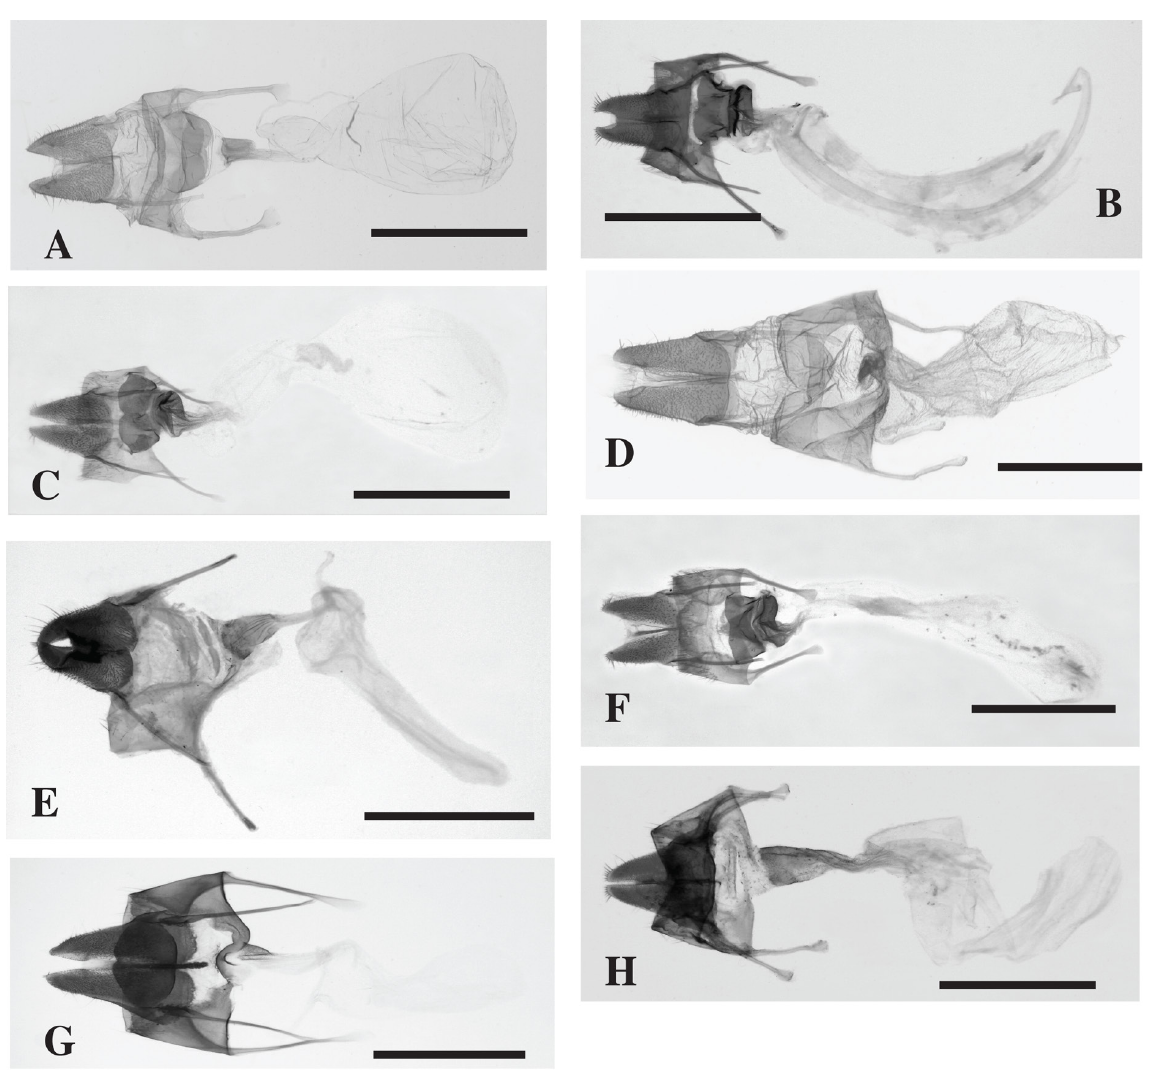
Fig. 3. Female genitalia of species of Acrapex . A . A. cuprescens (Hampson, 1910). B . A. kafula le